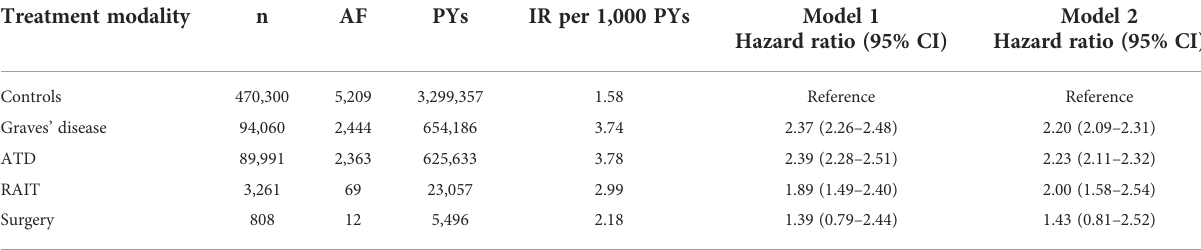
TABLE 2 Risk of atrial fi brillation among patients with Graves ’ disease according to treatment modality. Treatment